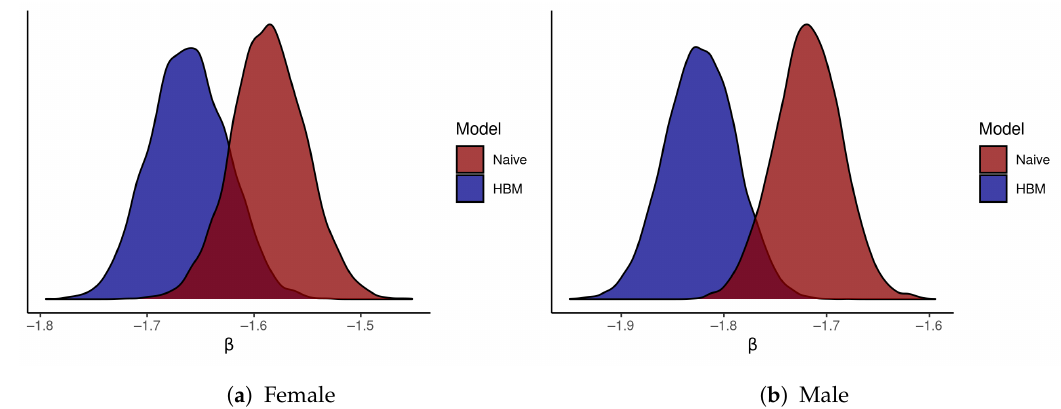
Figure 12. A comparison of the posterior probability density for β , the ICE-mortality gradient, given the full HBM with its density given only a ‘naive‘ spatial model that ignores observational uncertainty.